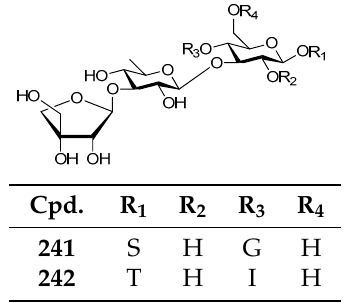
Figure 48. Structures of compounds 241 – 242 .